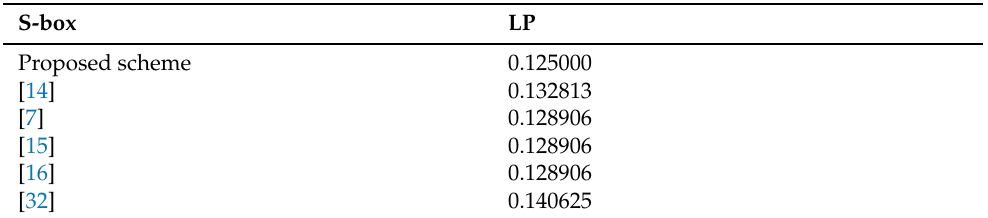
Table 11. A comparison of Linear approximation probability (LP).